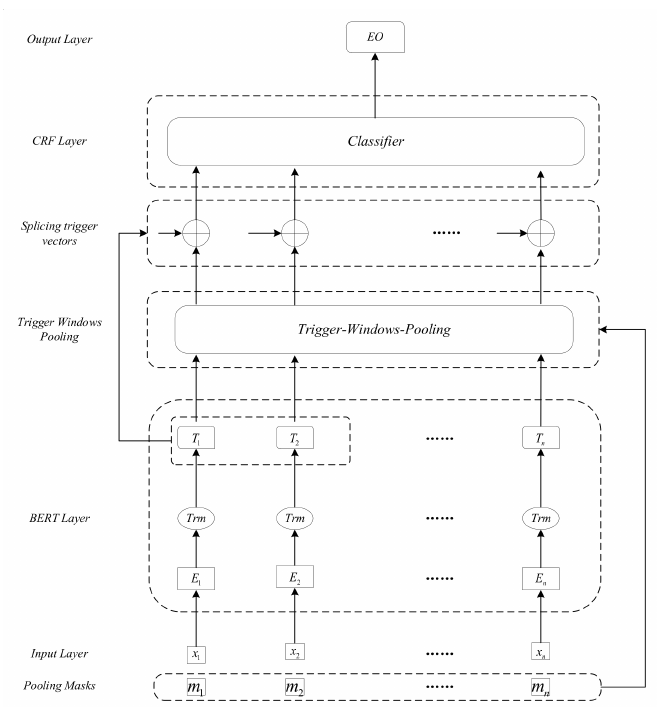
Figure 6. Structure of attribution classification